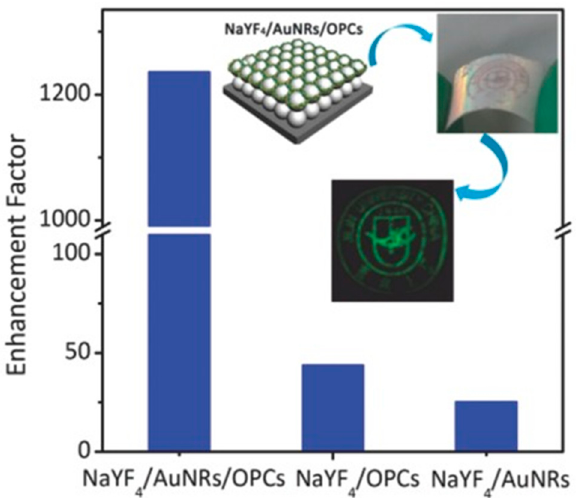
Figure 6. Enhancement factor of NaYF 4 /Au nanorods (NRs)/opal photonic crystals (OPCs), NaYF 4 /OPCs, and NaYF 4 /Au NR hybrids. The insets: schematic illustration of NaYF 4 /AuNRs/OPCs hybrids, optical image of flexible OPCs on a polyethylene terephthalate (PET) film, and a digital image of a flat flexible upconversion nanoparticles (UCNPs) film taken in a dark room under the excitation of a 980-nm laser. Adapted from [47], with permission from © 2016 John Wiley and Sons.